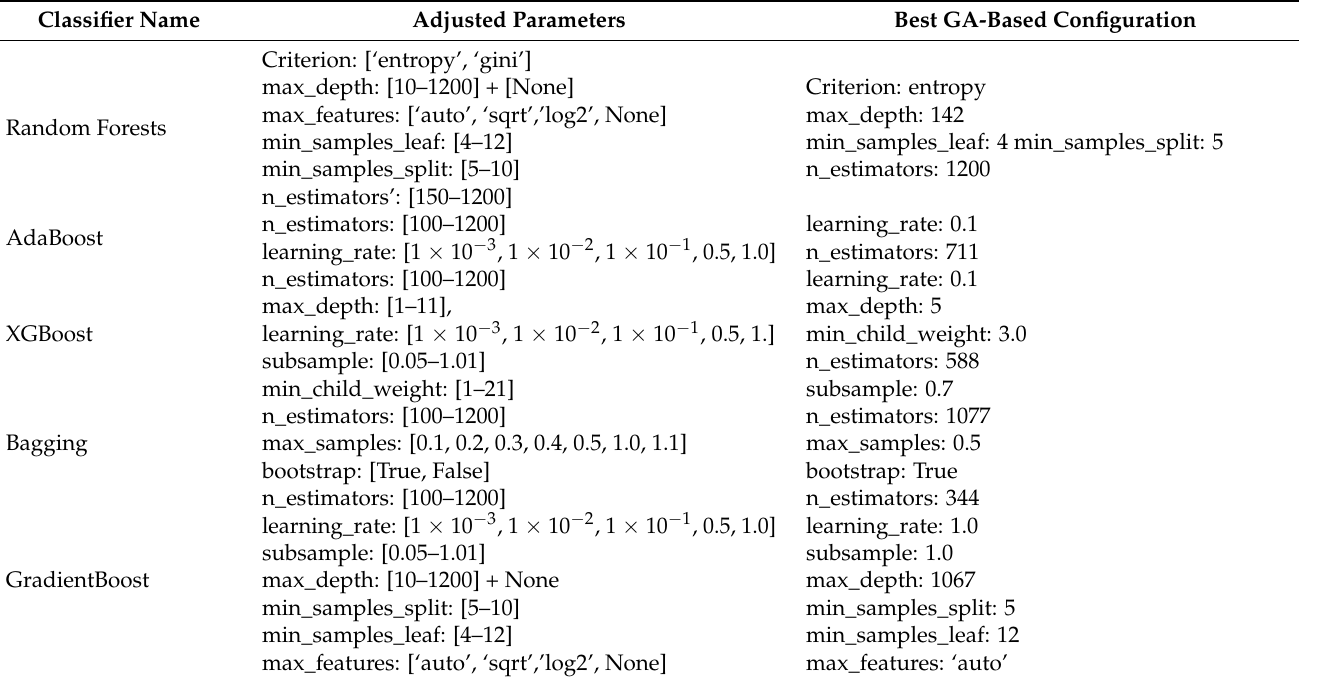
Table 6. List of optimized parameters of the